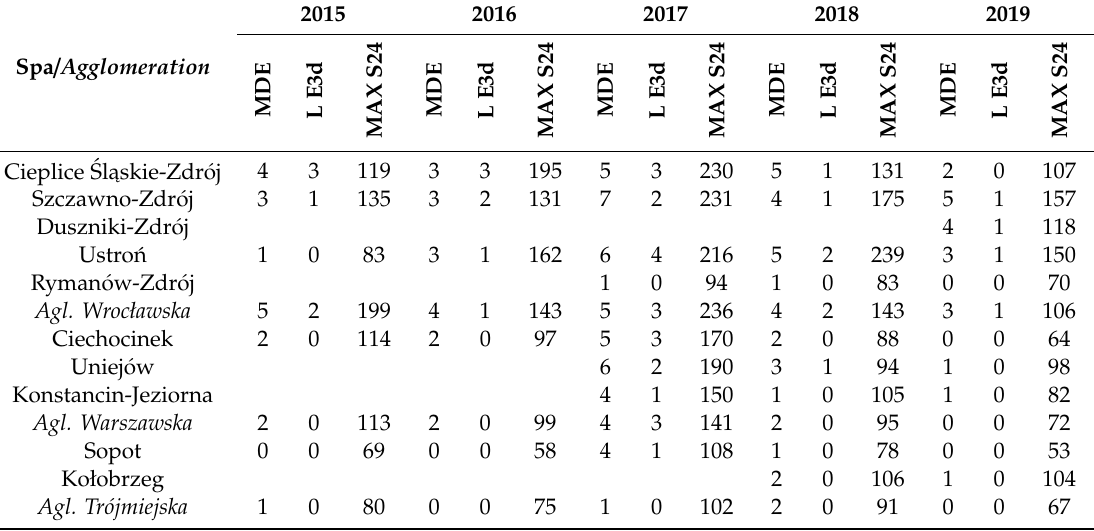
Table 5. Indicators characterizing episodes of high PM 10 concentrations in the analyzed spas and agglomerations in